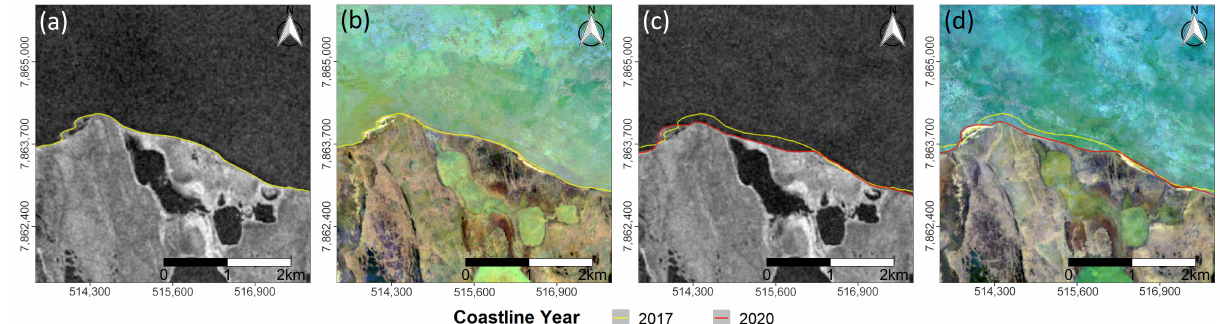
Figure 7. Subsections of Cape Halkett in the USA (aoi 02) in the year 2017 ( a , b ) and 2020 ( c , d ). Median images (months June–September) from S1 in VV polarization ( a , c ) and S2 in RGB ( b , d ) are shown together with the manually digitized reference coastlines for the years 2017 (yellow line) and 2020 (red